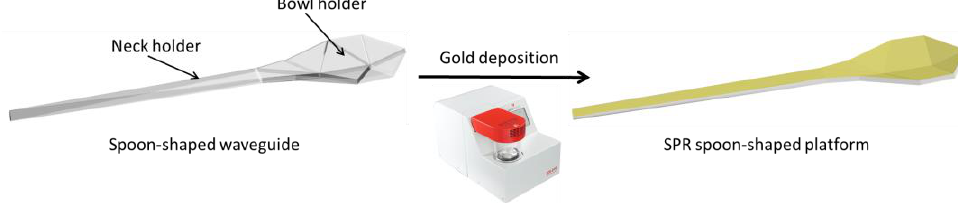
Figure 1. Outline of fabrication process for the SPR sensor based on the spoon-shaped